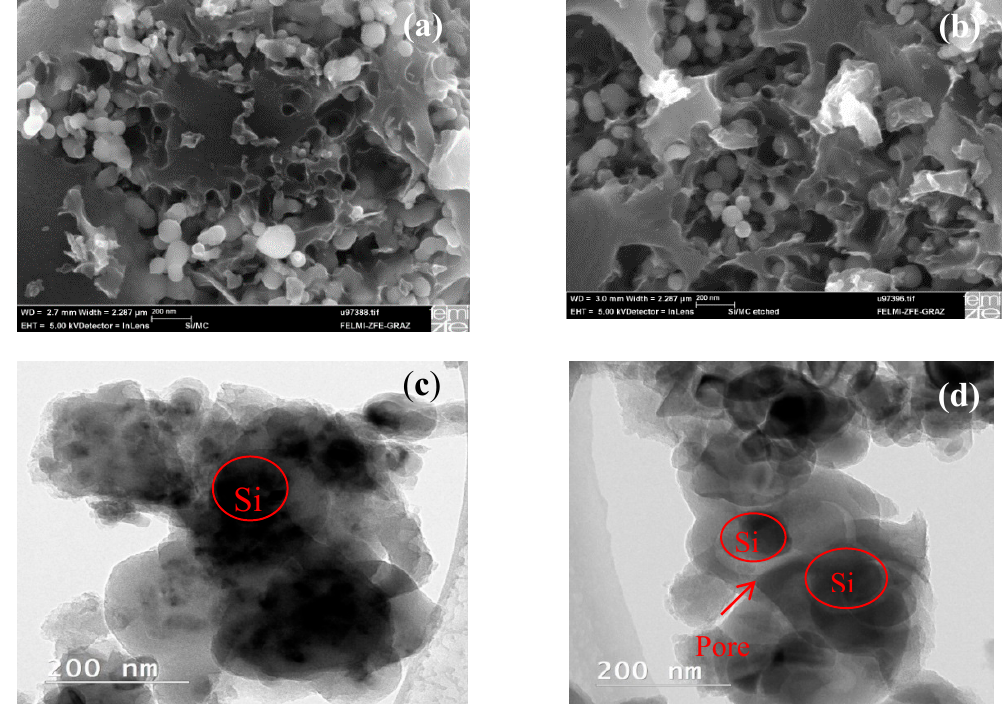
Figure 2. SEM images of Si/MC composites before ( a ) and after ( b ) etching, TEM images of the Si/MC composites before ( c ) and after ( d ) etching.